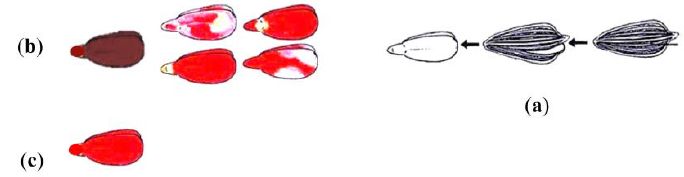
Figure 2. ISTA based embryo death assessment: ( a ) Seed preparation and coat removal method; ( b ) Unacceptable staining types that are considered abnormal seeds; ( c ) Uniform staining of live seed.